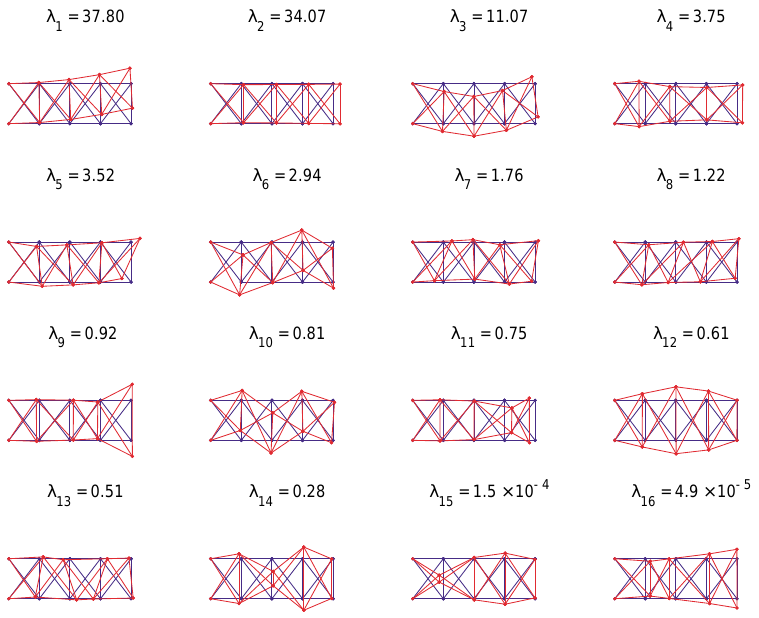
Fig. 6. Proper orthogonal modes with respective mean energies for horizontal impulsive force applied at node